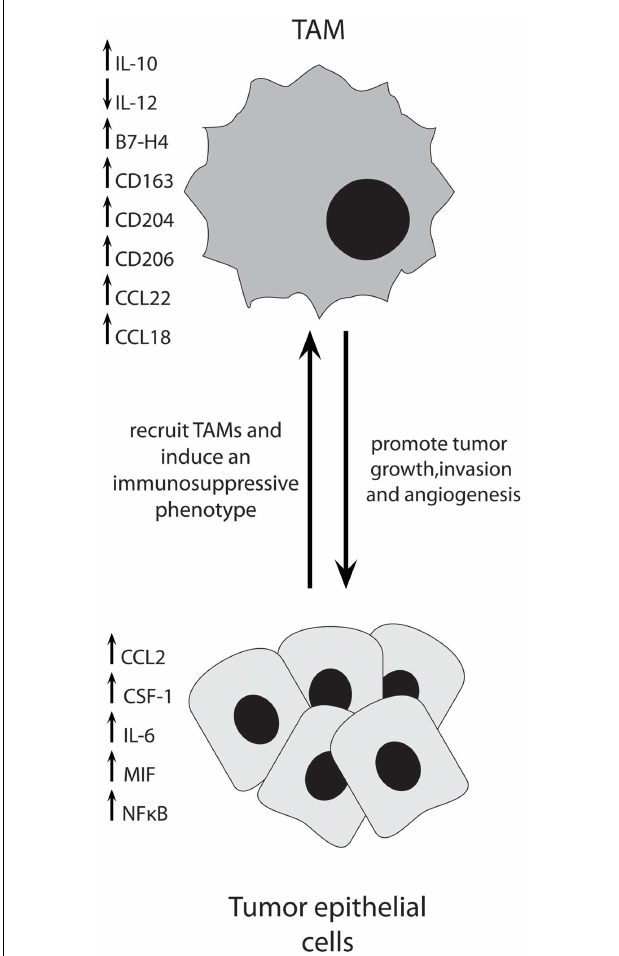
FIGURE 1 | Ovarian cancer cells produce multiple factors to recruit immunosuppressiveTAMs into the tumor, where they act to promote tumor progression through multiple mechanisms